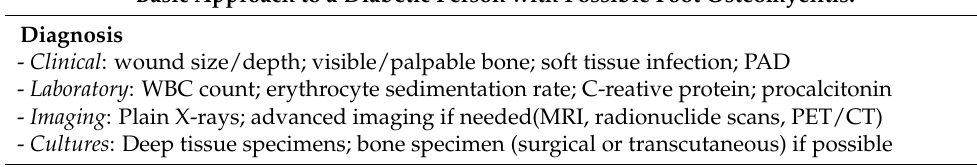
Table 2. This is a brief table reminding clinicians of the basics of approaching the diagnosis and treatment of suspected diabetic foot osteomyelitis. Please refer to the text for more detail. Basic Approach to a Diabetic Person with Possible Foot